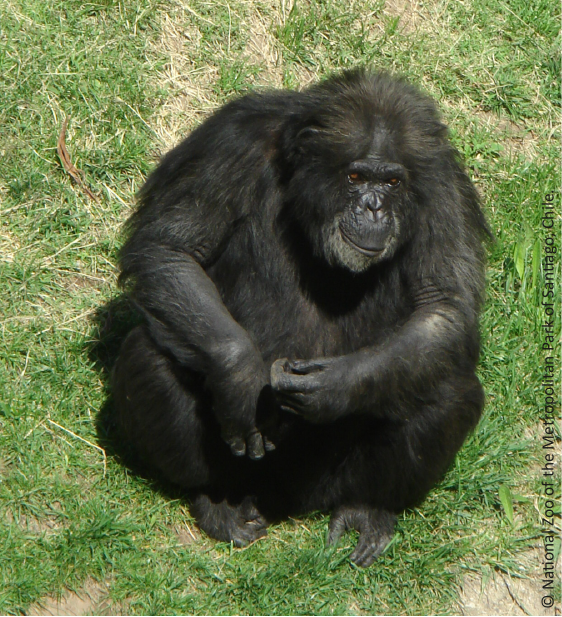
Image 4. Specimen 3 - Pan troglodyte s troglodytes